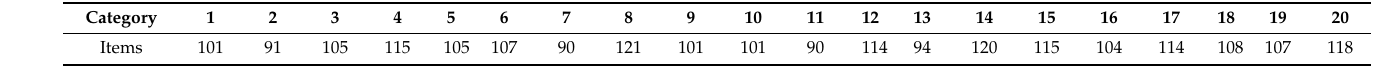
Table 1. Different providers or categories and their number of items.